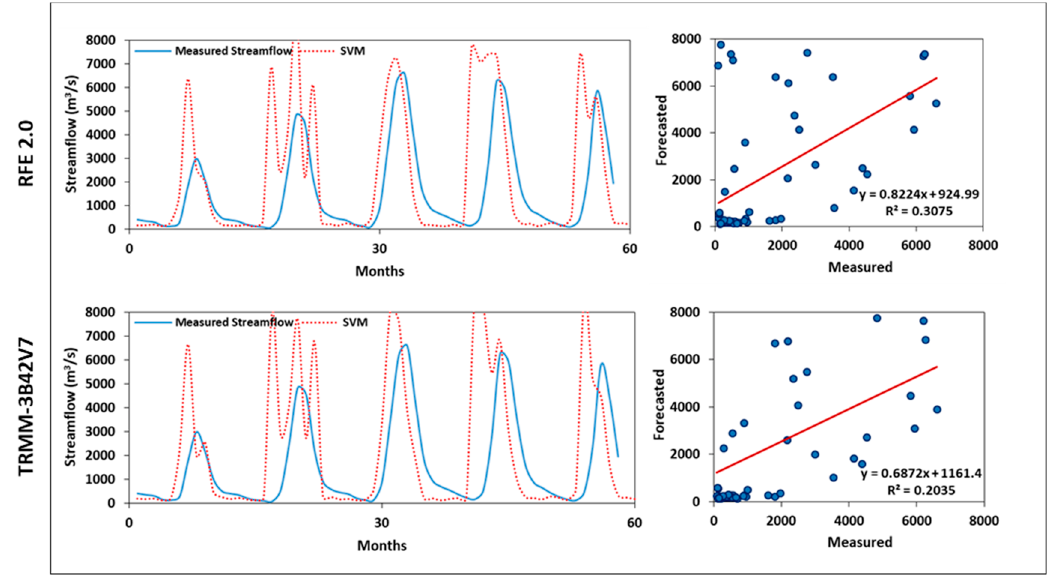
Figure 10. ANN test results of the simulated monthly streamflow at El Diem station based on TRMM-3B42V7 and RFE 2.0 data.